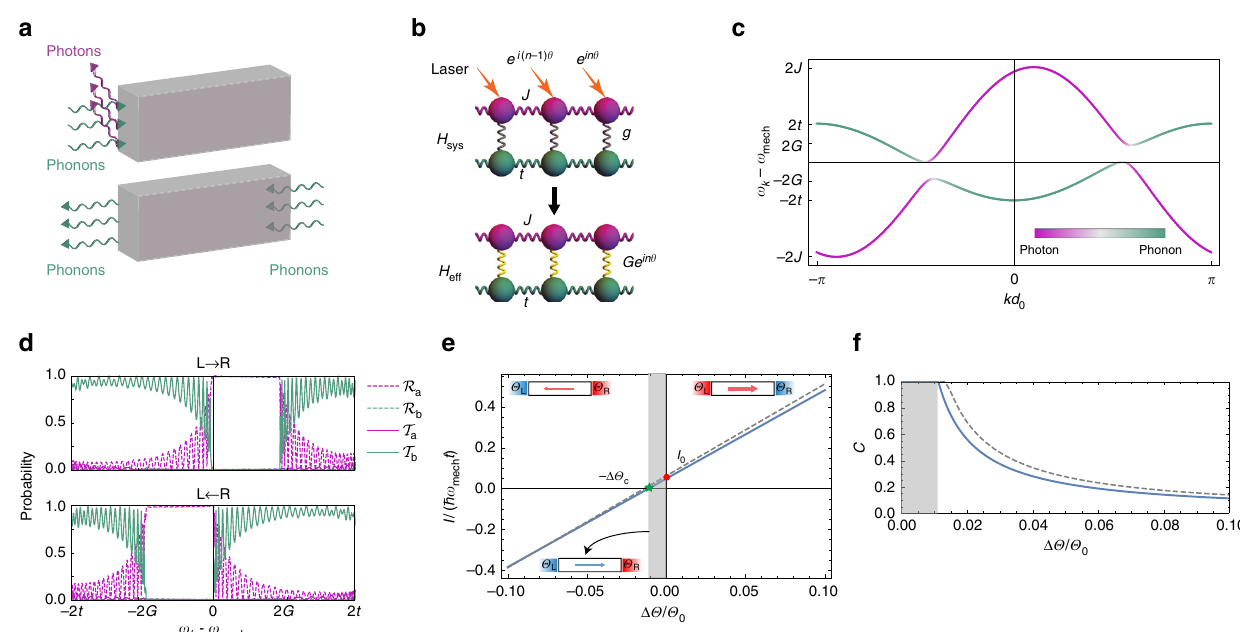
Fig. 1 Sketch of the system and its transport properties. a The non-reciprocal device allows transmission of phonons in one direction, and converts them into photons, which are re fl ected in the opposite direction. b Schematic representation of the system, showing the coupling of phonon (green) and photon (pink) degrees of freedom and their hopping strengths t and J , respectively. Adding a driving laser with a phase e i n θ to the bare Hamiltonian H sys (3) with optomechanical coupling g leads to the effective Hamiltonian H eff (4) with an enhanced and position dependent optomechanical coupling Ge i n θ . c The band structure corresponding to the Hamiltonian in eq. (6) for parameters 2 G / t = 1, 2 J / t = 5, and θ = 1.1 π ( k is the wavenumber appearing in the eigenmodes ^ b ^ a α þ β T fl ection k ; j k (cid:2) θ k ). The color scale indicates the extent of phonon (green) or photon (pink) character of the eigenstate. d Transmission a ð b Þ and re k ; j R → R) and left-moving (L ← R) phonons through a system with N = 100 sites plotted as a a ð b Þ probabilities of photons (phonons) for right-moving (L function of incident energy. The gaps in c , determine the energy range for which phonons are re fl ected from the system. The mismatch in these energy ranges for left- and right-moving phonons is the origin of the non-reciprocal transport. e The current I as a function of temperature bias for the same parameters as c , and k B Θ 0 / ħ ω mech = 1.5. The non-reciprocity is evident in the non-zero intercept of the line in I - Δ Θ plot. A key feature is that a non-zero current I 0 fl ows even in the case of zero bias. When the bias is − Δ θ c the current is extinguished. f Contrast C as a function temperature bias Δ Θ . The shaded region in e , f corresponds to the case with C = 1, in which if the bias is reversed, the direction of the current is unchanged. The solid lines in e , f correspond to the Eqs. (8) and (12), whereas the dashed lines represent approximate expressions (13) and